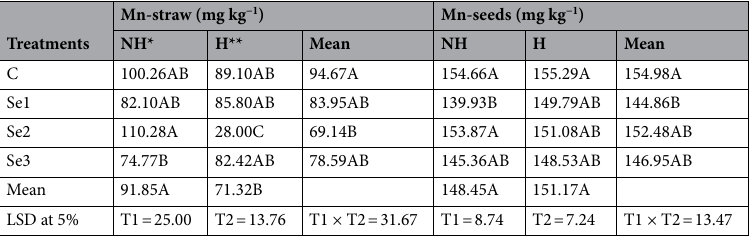
Table 10. Effects of Se and K-humate application on Mn content. *Refers to Se application without K-humate. **Refers to the simultaneous application of Se and K-humate.